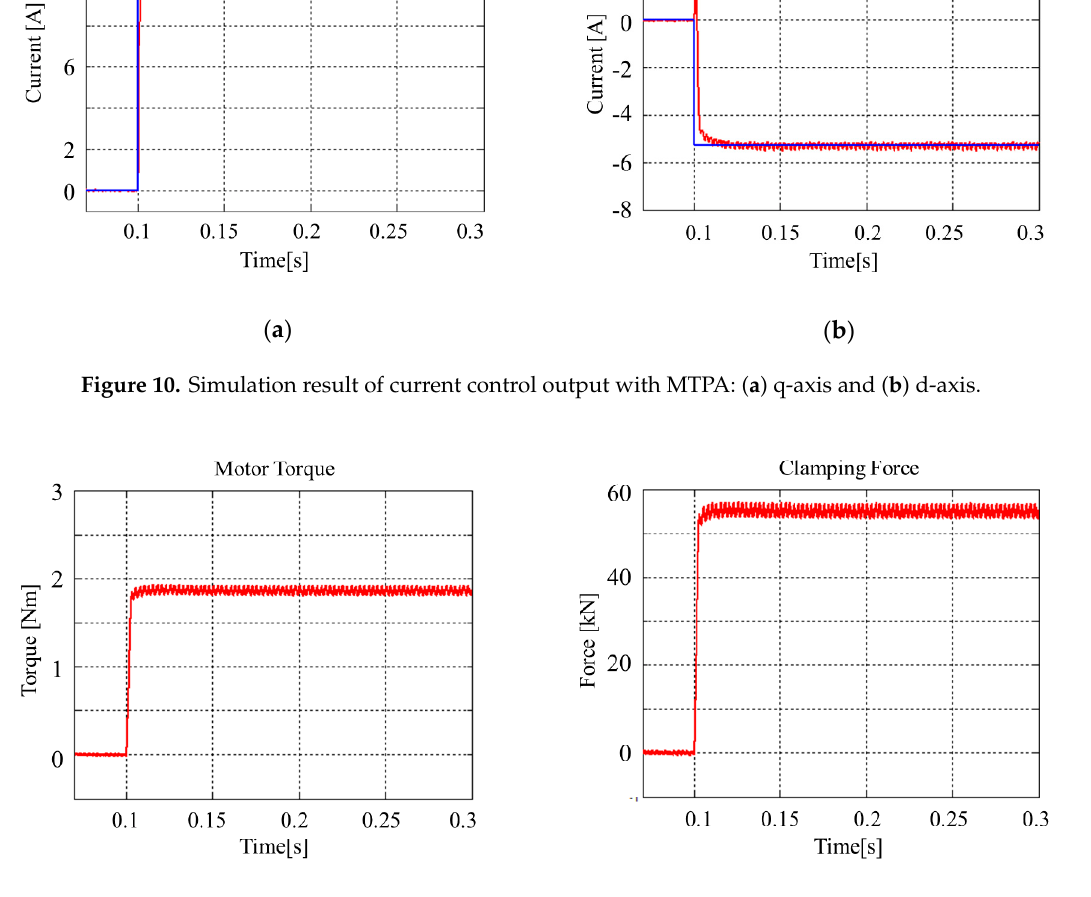
Figure 11. Simulation result of mechanical output with MTPA: ( a ) motor torque and ( b ) clamping force.